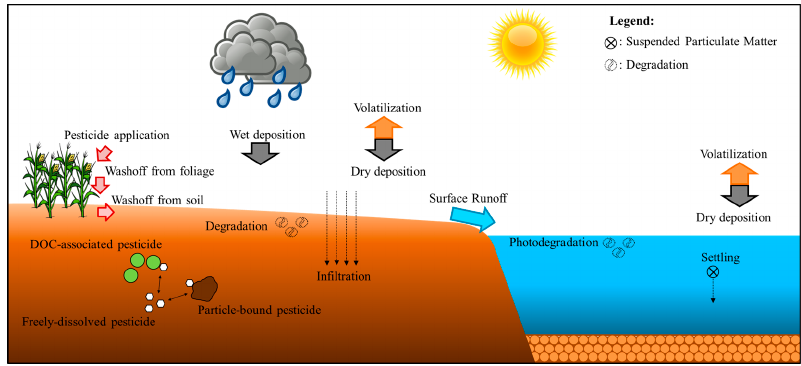
Figure 3. Fate and transport diagram of pesticides in the environment with the modified SWAT model. The three-phased partitioning model approach that we applied for the pesticide was also